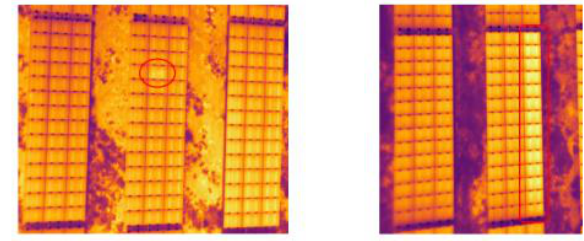
Figure 3. Deep CNN image classification Pipeline